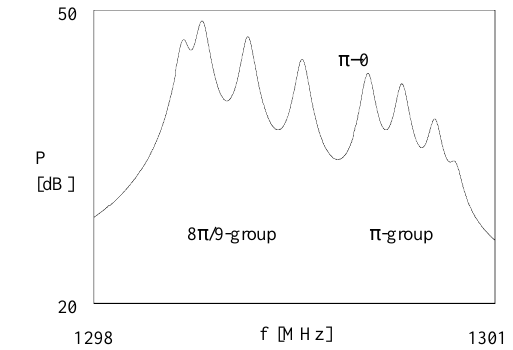
FIG. 6. Modes from the (cid:56) p (cid:121) (cid:57) group and the p group when (cid:81) (cid:48) (cid:173) (cid:50)(cid:46)(cid:53) 3 (cid:49)(cid:48) (cid:52) .